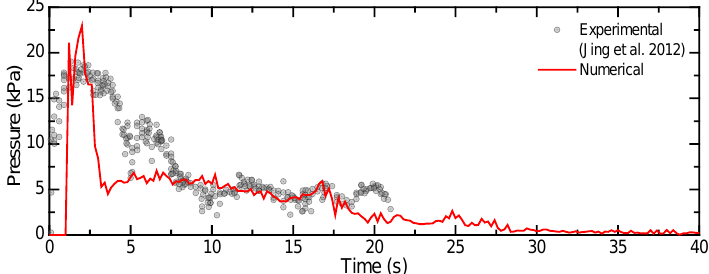
Figure 6. Comparison of slurry impact pressure vs time at the start of the sharp bend.